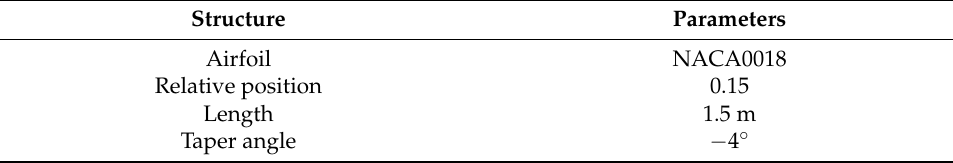
Figure 19. Hovering aerodynamic characteristics under different rotor root angles. RL and Mk are fitted within the collective pitch range, and the fitting degree meets engineering requirements after CFD validation as shown in Figures 20 and 21.